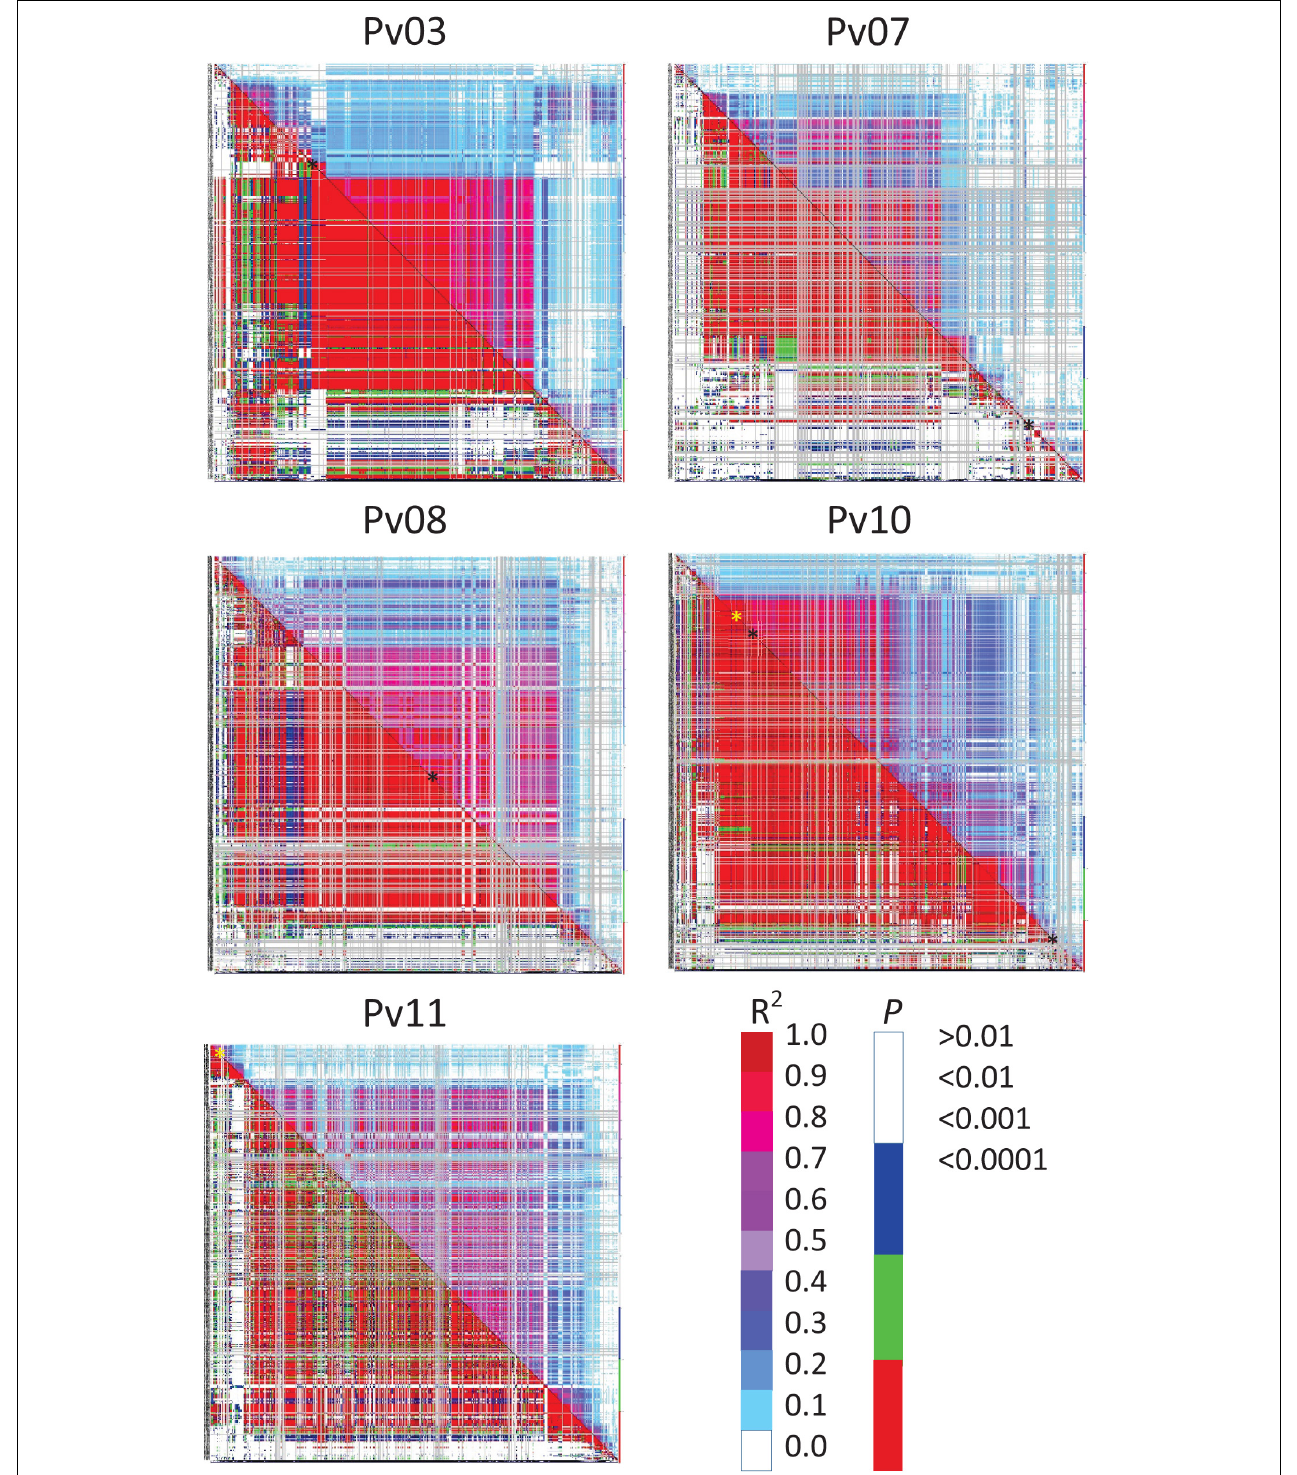
FIGURE 2 | Linkage disequilibrium (LD) heat map of common bean chromosomes Pv03, 07, 08, 10, and 11 showing all possible pairwise comparisons of SNPs arranged along the chromosome. R 2 values are displayed above and right of the diagonal and corresponding probabilities below and left of the diagonal. Color scales show corresponding R 2 and probabilities where red for each would indicate strong and highly significant LD. SNPs associated with disease severity (black ∗ ) or biomass (yellow ∗ ) are indicated along the diagonal.